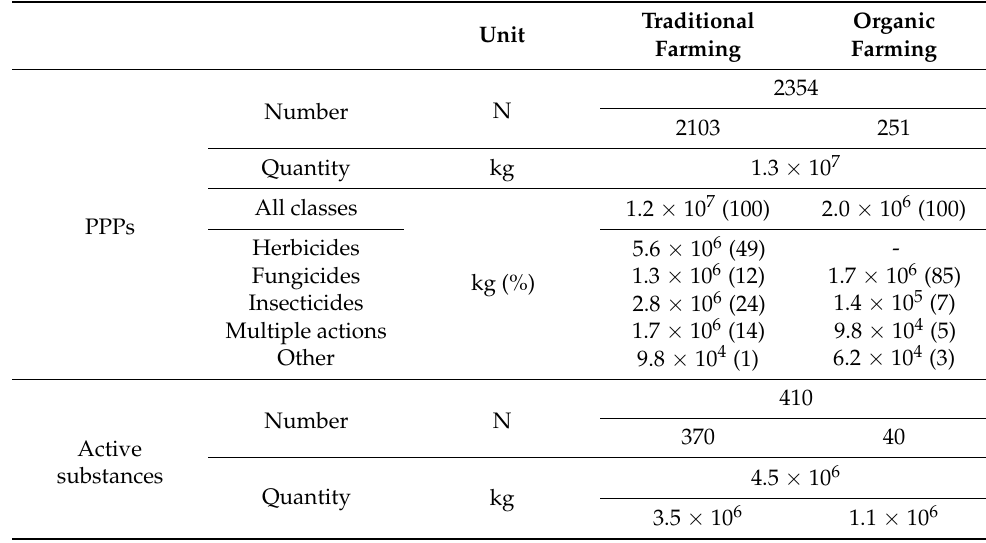
Table 2. Summary of the number (N) and quantity (kg) of PPPs sold in Lombardy in 2016, and active substances therein contained, divided into traditional farming and organic farming prod- ucts/substances.